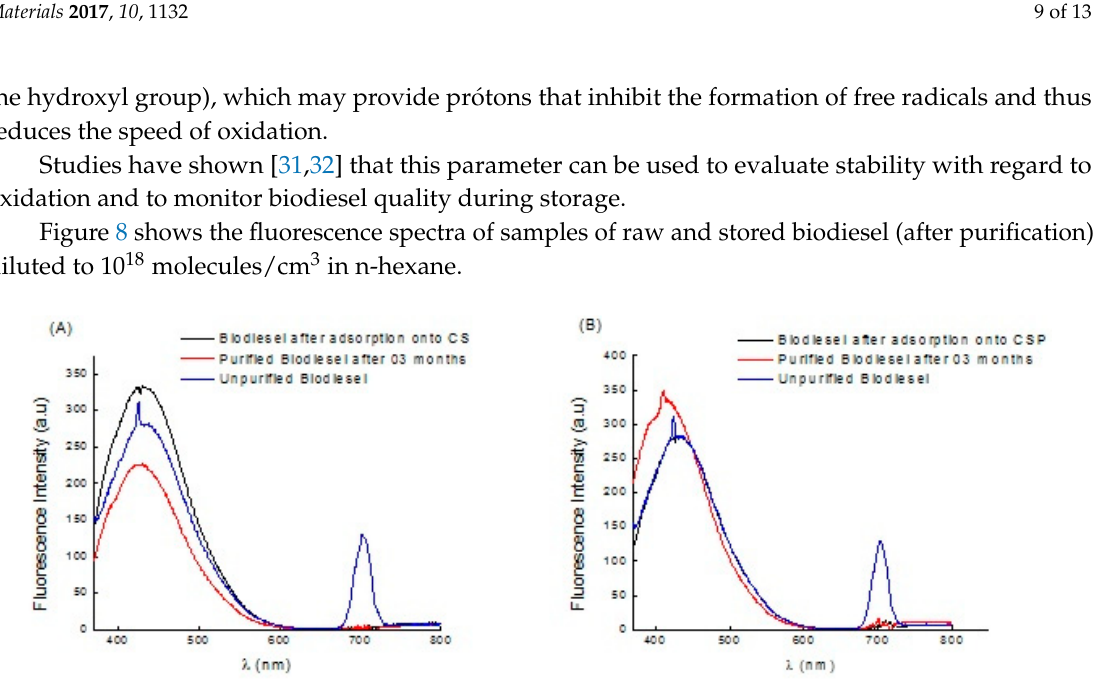
Figure 8. Fluorescence spectra for biodiesel alone and biodiesel after adsorption by ( A ) CS and ( B ) CSP.